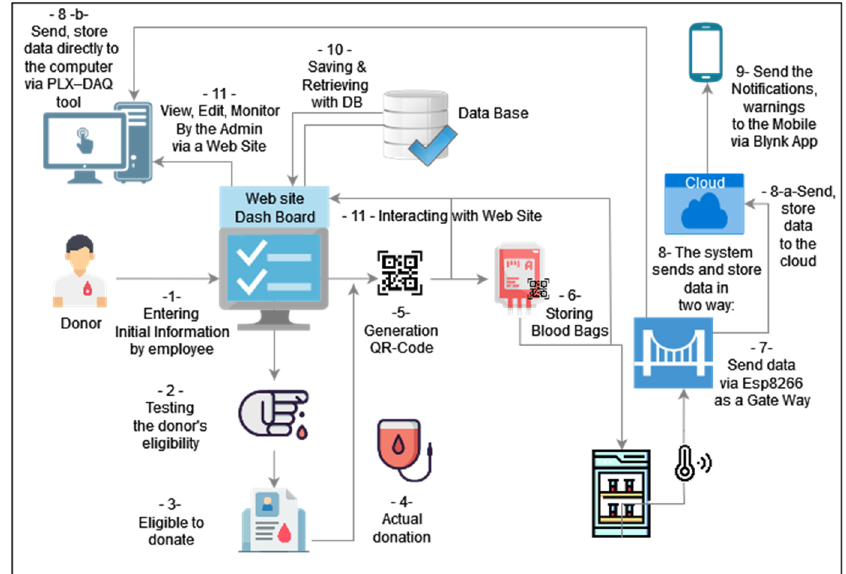
Figure 10. The overview of the entire proposed system.